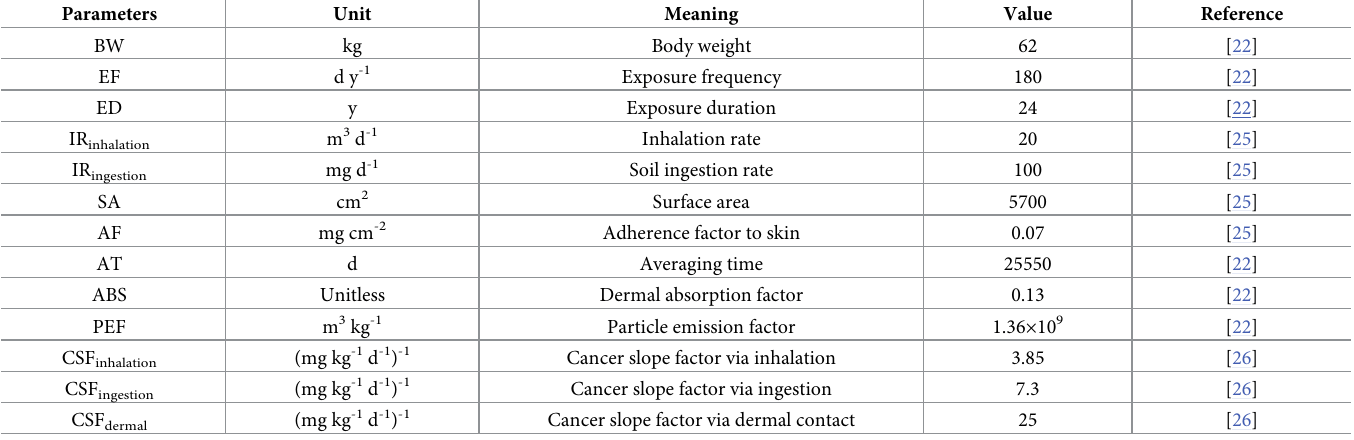
Table 3. Exposure parameters used in the incremental lifetime cancer risk (ILCR) assessment.